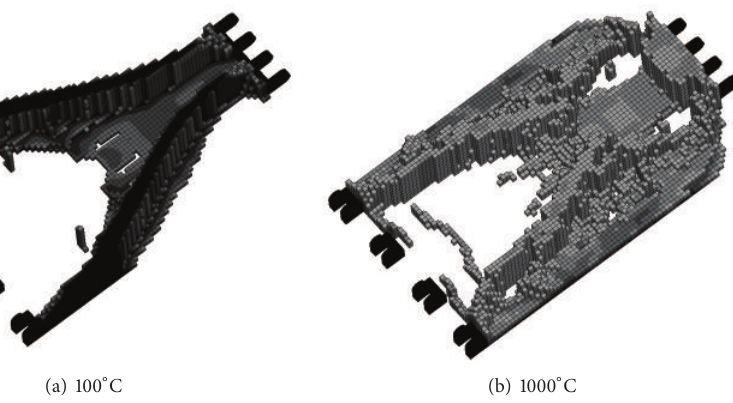
Figure 9: Topological optimized design with different temperature increases.